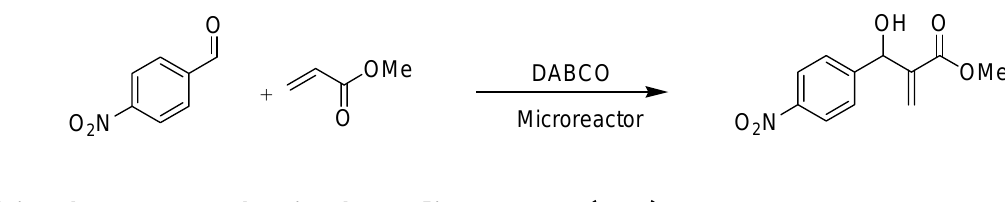
Scheme 25. MBH reaction between 4-nitrobenzaldehyde and methyl acrylate obtained online using a